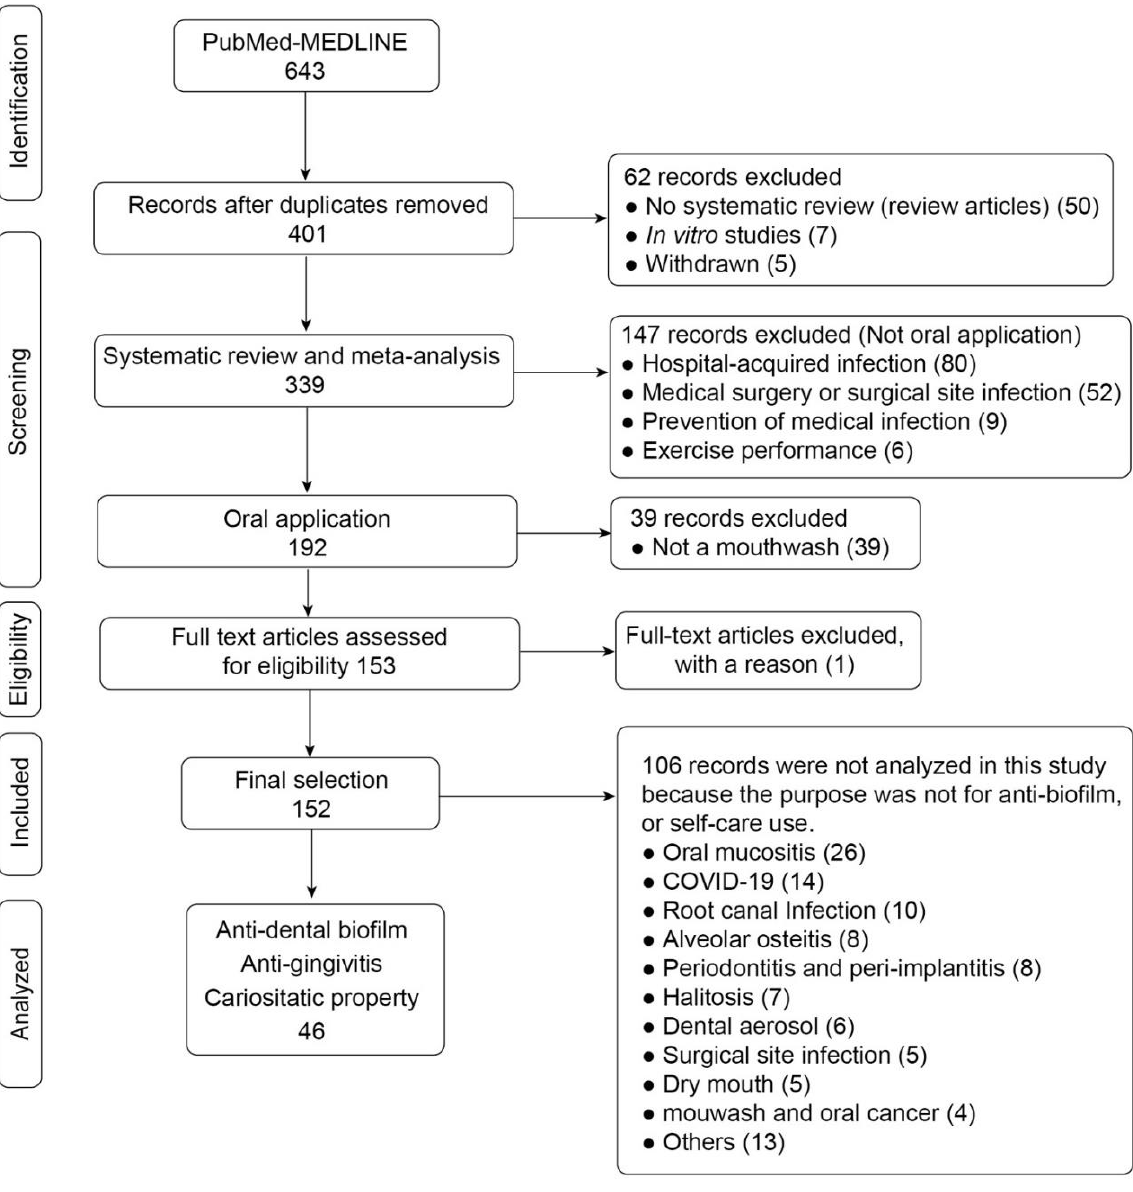
Figure 3. Flow diagram of the screening and selection process.